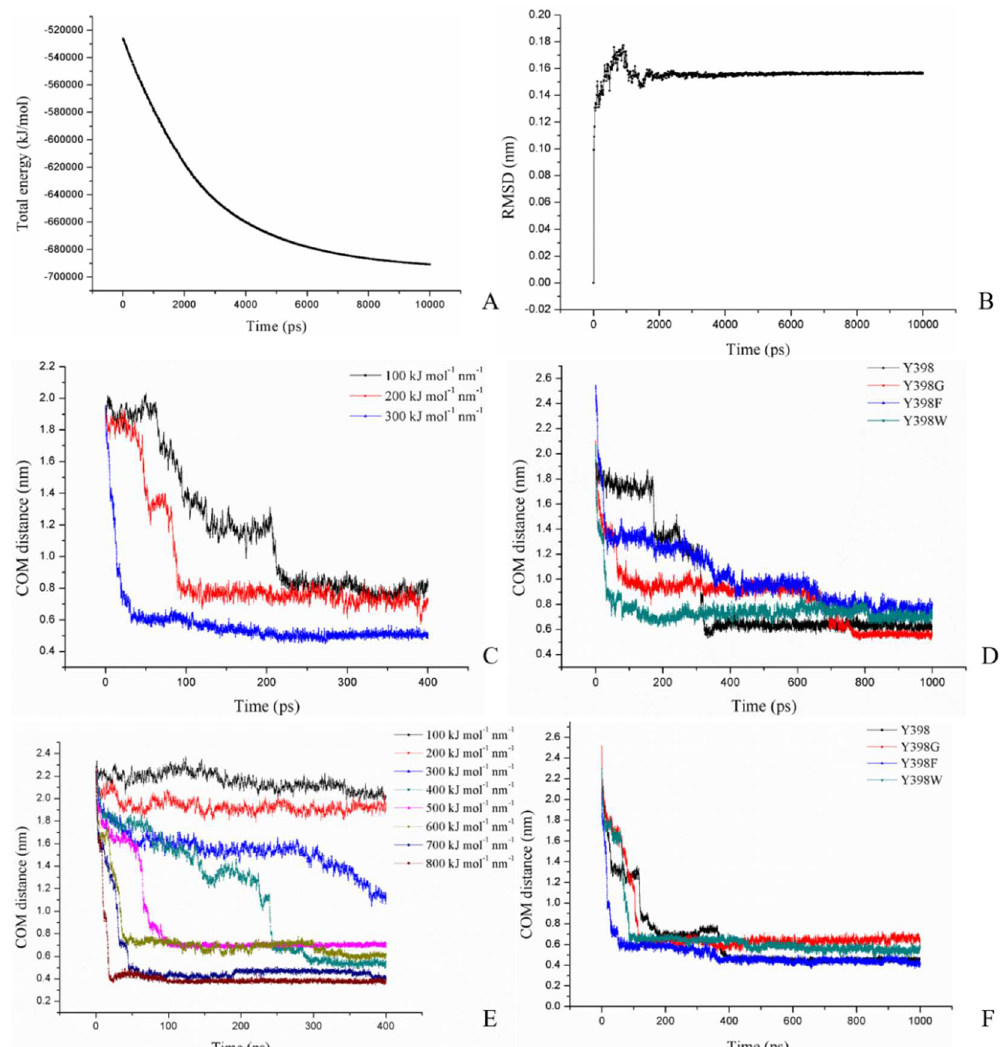
Figure 5. Molecular dynamic and pulling force results. ( A ) protein energy of model 1, ( B ) rms deviations of model 1, ( C ) center of mass (COM) distance changes of ATChI and S266 of model 1 under different constant pulling forces as indicated, ( D ) COM distance changes of ATChI and S266 with pulling force of 200 KJ · mol − 1 · nm − 1 for the different mutants, ( E ) COM distance of Carbofuran-3-hydroxy and S266 under different constant pulling force, and ( F ) COM distance of Carbofuran-3-hydroxy and S266 with pulling force of 400 KJ · mol − 1 · nm − 1 for the different mutants as indicated.